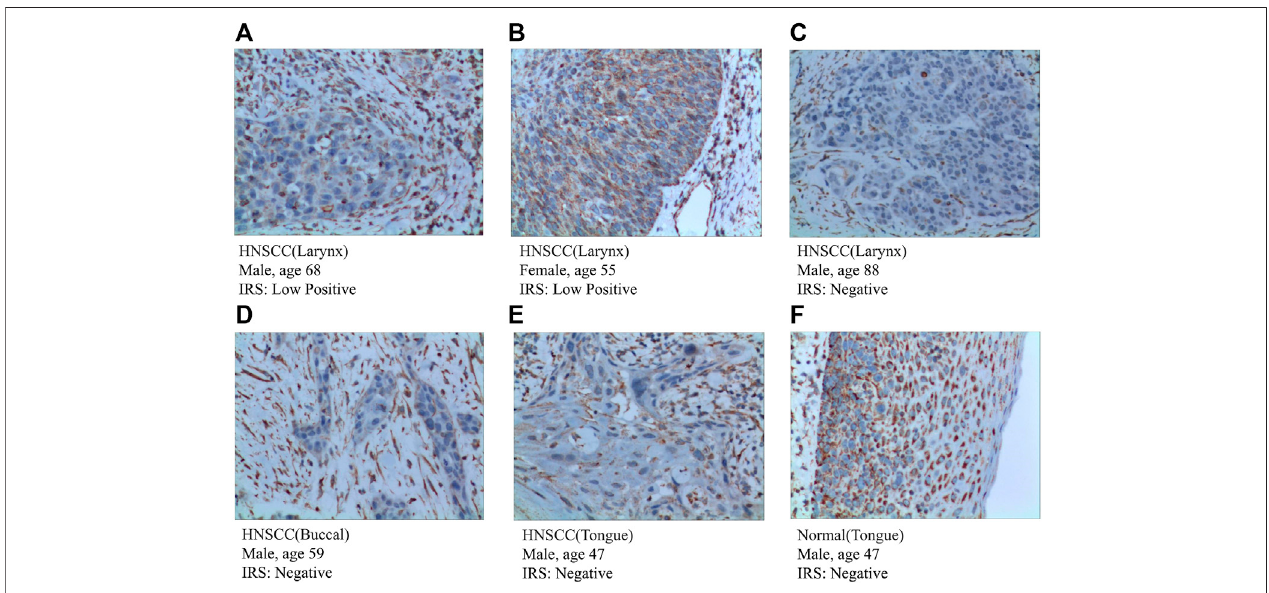
FIGURE 8 | IHC analysis of the protein expression of IGHG2 in HNSCC and normal tissues. (A – E) The expression of IGHG2 was detected by IHC in fi ve patients with HNSCC (Magni fi cation ×200). (F) The expression of IGHG2 was detected by IHC in normal head and neck squamous cell tissue (Magni fi cation ×200).